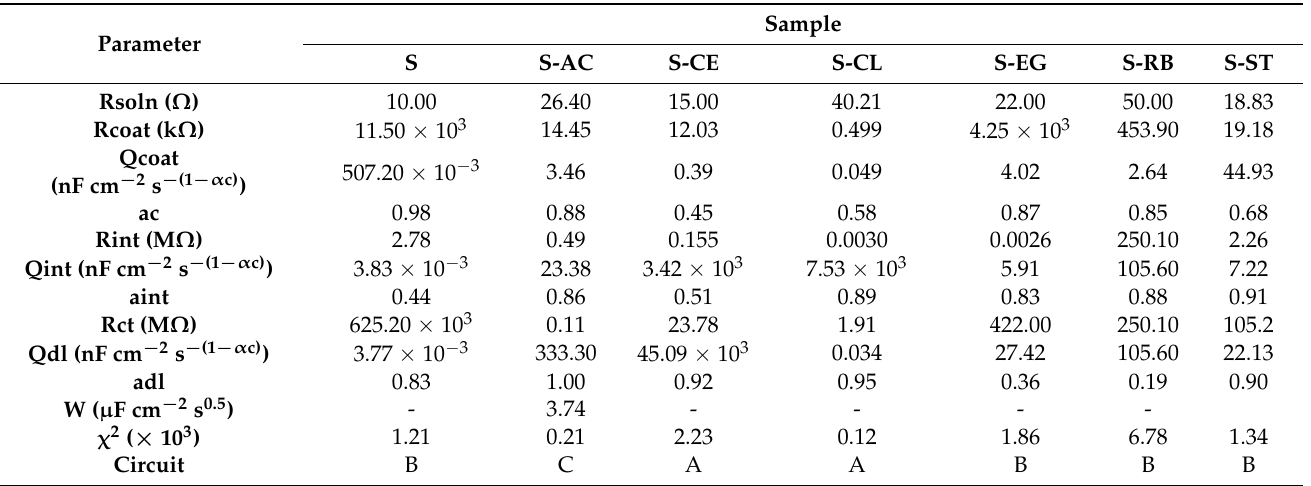
Table 4. EIS circuit fitted parameters for the S-coating matrices on AA3003 substrate after 30 days of exposure to 3.5 wt.% NaCl solution.